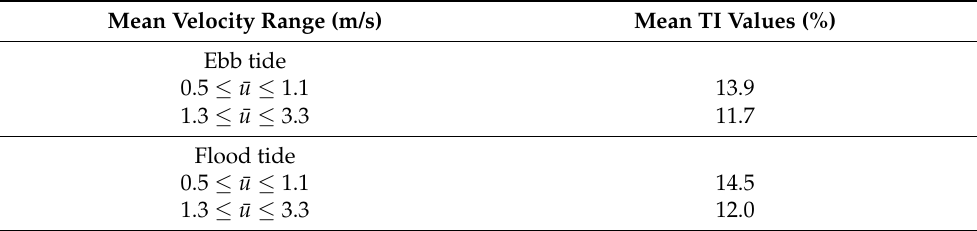
Table A1. TI values used to generate time series of tidal stream velocity [2].